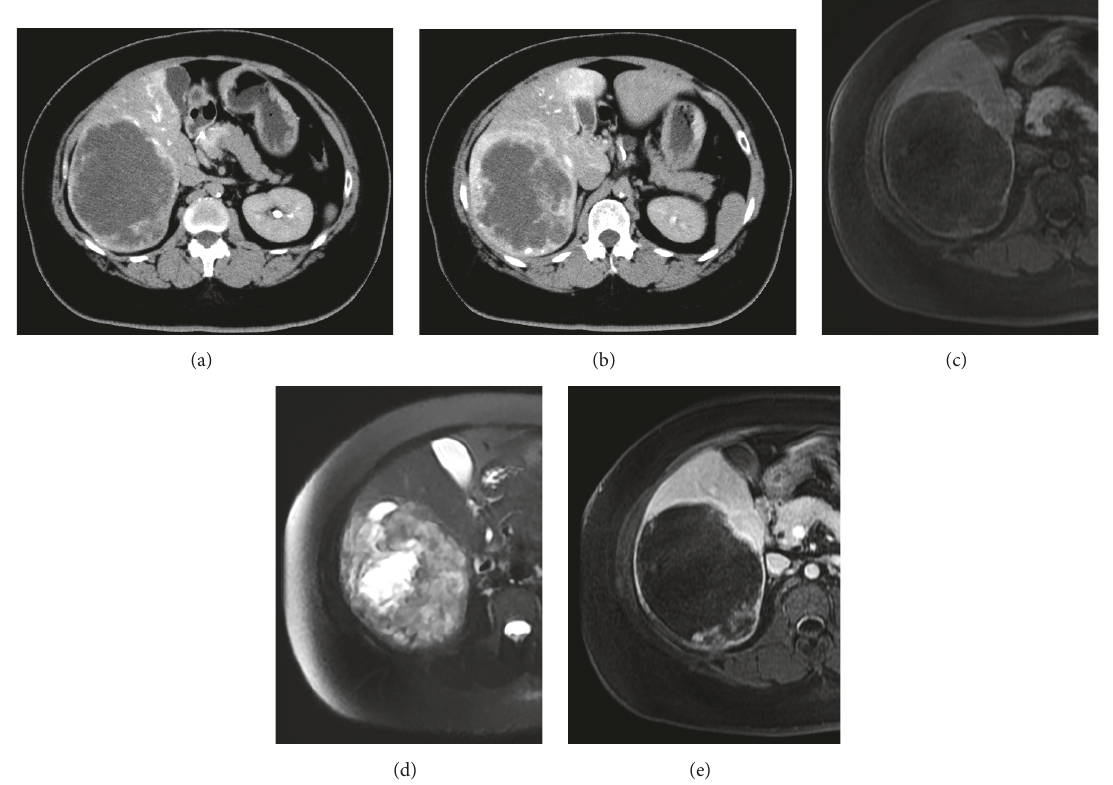
Figure1: Abdominalcomputedtomographyduringhepaticangiographyandmagneticresonanceimaging. ArterialphaseCTscanshows a geographic lesion in the right lobe of the liver with a rim and nodular enhancement (a), and the delayed phase of CT reveals heterogeneous enhancementin the peripheral area of the mass with a gradual centripetal enhancement pattern (b). The tumor shows low signal intensity on T1-weighted images (c) and some high-signal intensity nodules on T2-weighted images (d). EOB-MRI shows no uptake in the corresponding area